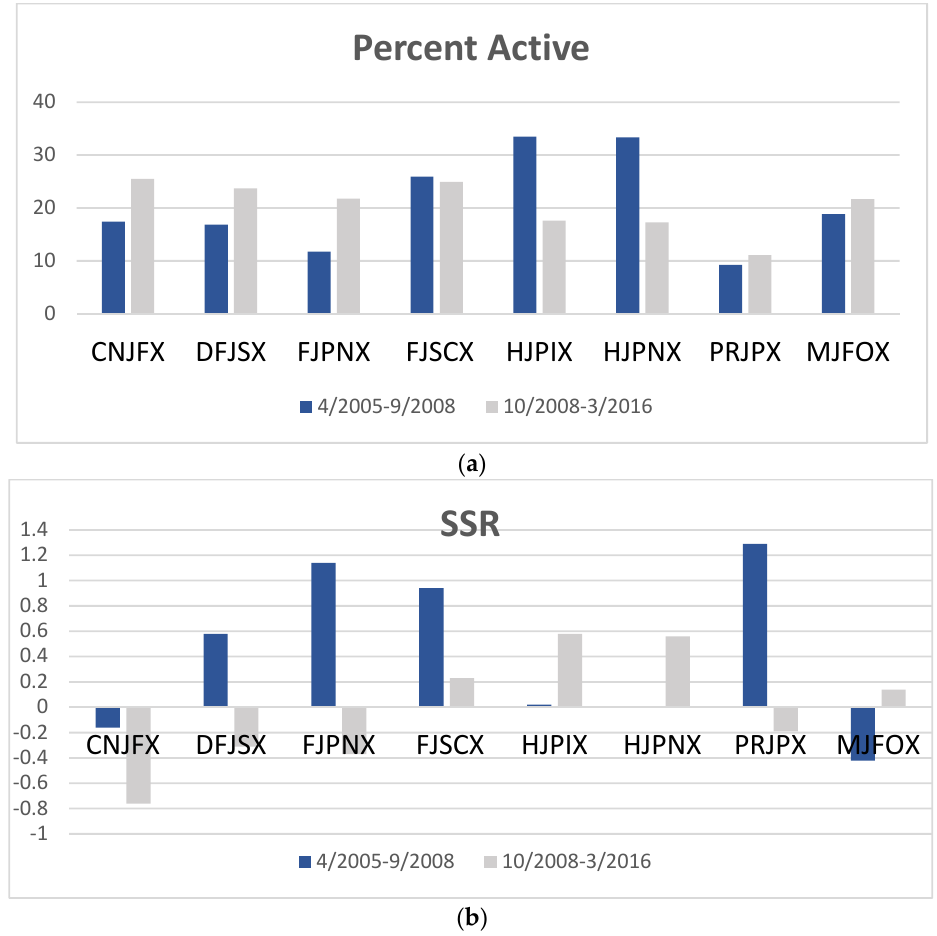
Figure 8. Percent active and Selection Sharpe Ratio (SSR) over the Pre-Lehman Brothers collapse and after the Lehman Brothers collapse periods. (a) Percent Active before and after the collapse of the Lehman Brothers (b) Selection Sharpe Ratio before and after Lehman Brothers collapse. Percent Active is expressed in percentages; SSR is expressed in absolute values.